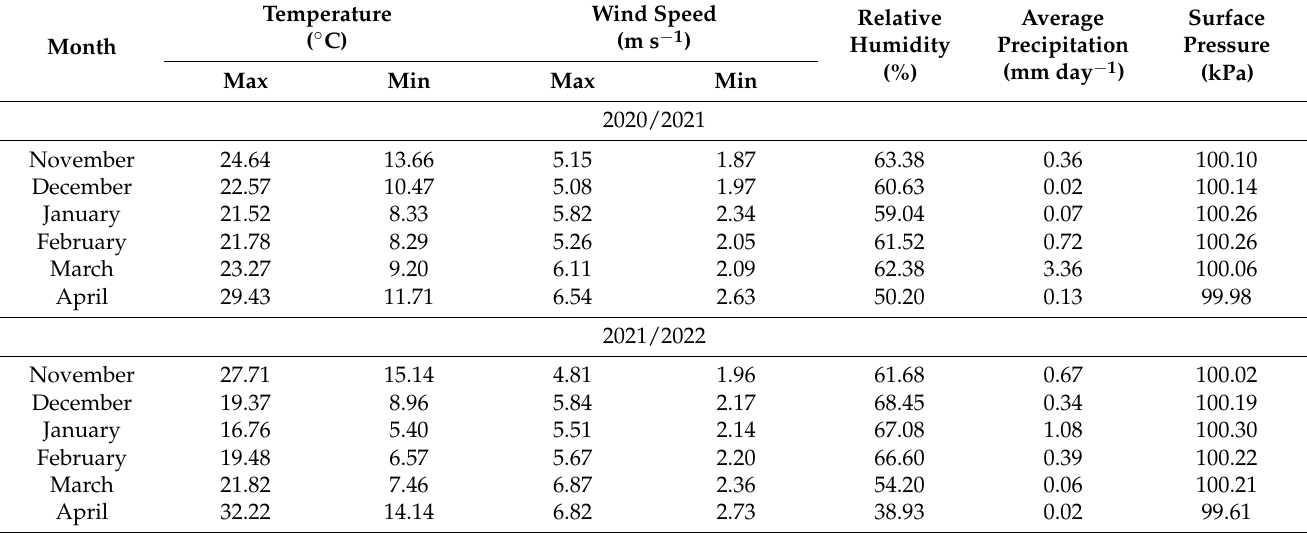
Table 1. Temperature ( ◦ C), wind speed (m s − 1 ), relative humidity (%), average precipitation (mm day − 1 ), and surface pressure (kPa) of experimental site during 2020/2021 and 2021/2022 winter growing